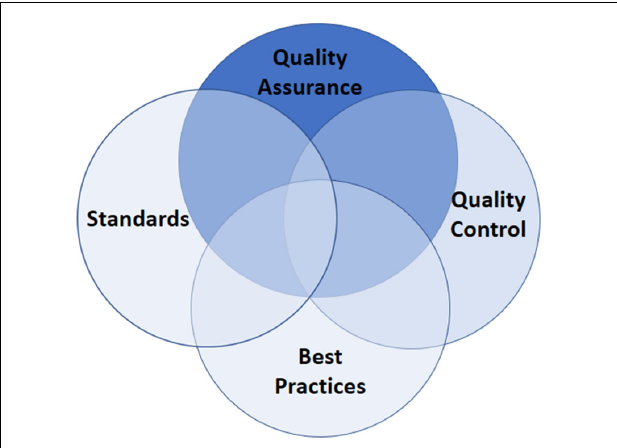
FIGURE 1 | Overlap of QA, QC, established standards, and best